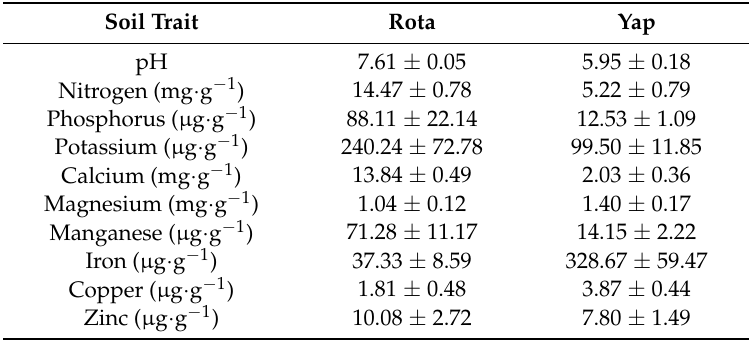
Table 1. Soil reaction and mineral and metal concentrations of Rota karst soils and Yap Schist soils in high density Cycas micronesica populations. Mean ± standard error, n =